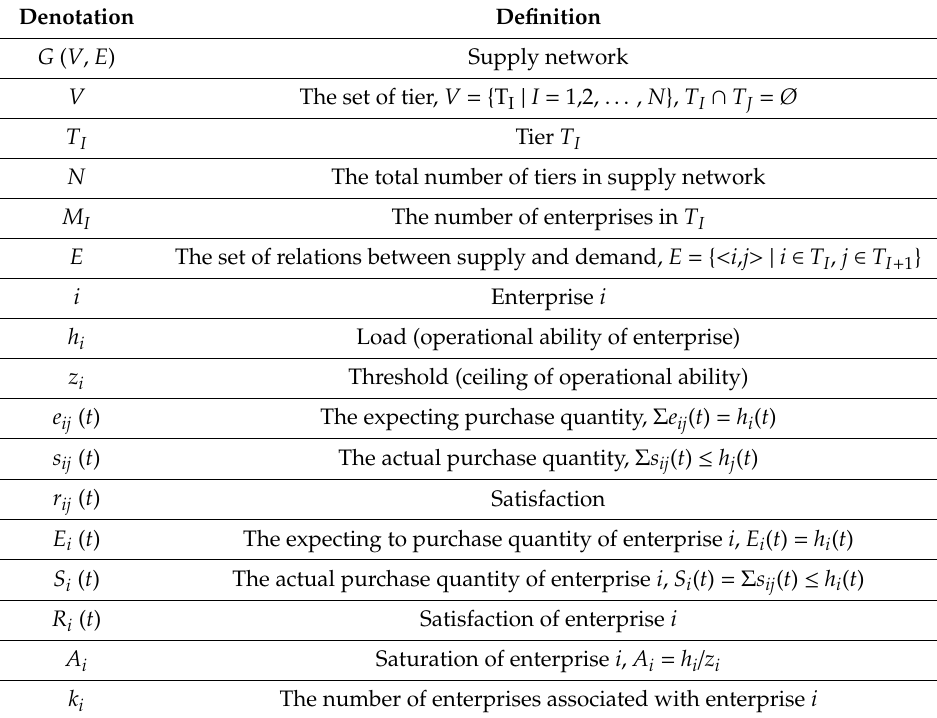
Table 1. Parameters for supply